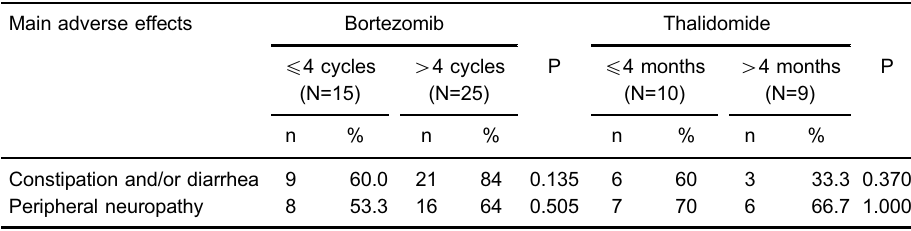
Table 7. Main observed adverse effects according to exposure time to bortezomib or thalidomide in multiple myeloma patients. Main adverse